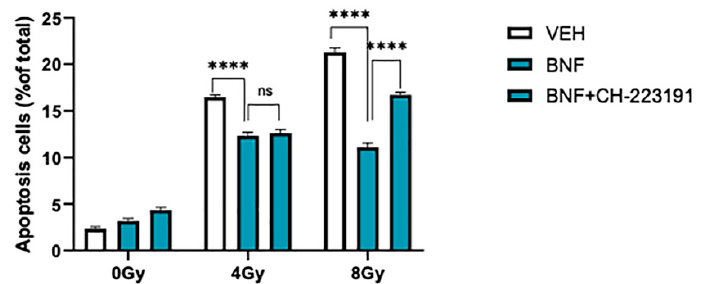
Figure 2. BNF protects cells from irradiation by regulating IEC-6 cells apoptosis. IEC-6 cells were tested for apoptosis after pre-treatment with 1 μ M BNF or 1 μ M BNF+ 1 μ M CH232191. Results are expressed as Mean ± SD and analyzed by one-way ANOVA (Significance: **** p < 0.0001). The term “ns” is defined as not significant.